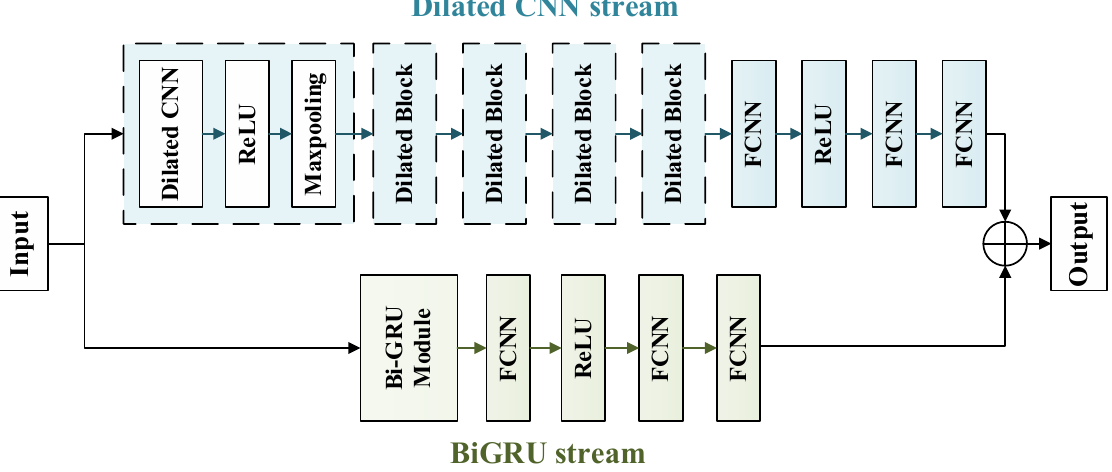
Figure 4. The overall network structure of the proposed dilated CNN-BiGRU.